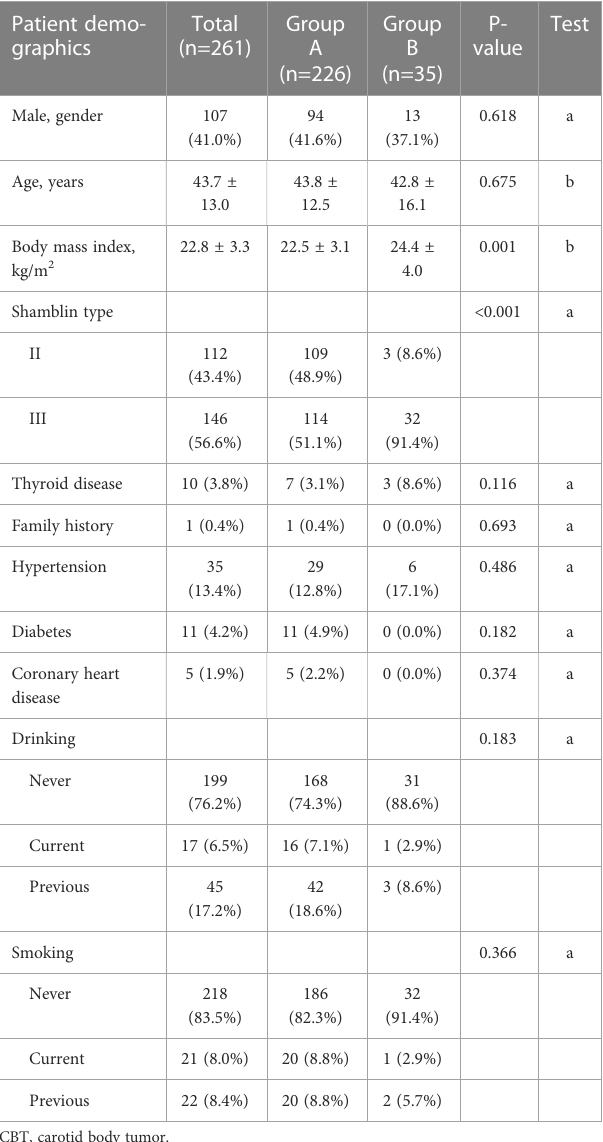
After 3 years of follow-up, no patient died in both groups. Only three patients with stroke were detected: 2/226 (0.9%) in group A vs. 1/35 (2.9%) in group B (p = .308). These independent risk factors were selected by using uni- (Table 2) and multivariable analysis (Table 3), including age, gender, BMI, Shamblin type, thyroid disease, drinking. The estimated OR for group B with group A as the baseline group was 3.3 (95% CI 0.3 – 37.3) (p = .336) and the adjusted OR (with age, female, BMI, Shamblin type, thyroid disease, and drinking as covariables) was 2.0 (95% CI 0.1 – 38.5) (p = .655). In these three patients with stroke, one in group A had clopidogrel